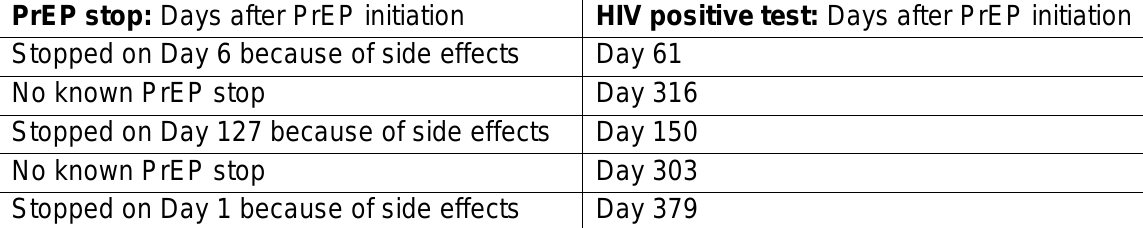
TABLE 3-A1. Timeline of PrEP stops among South African men who have sex with men and transgender women in a combination HIV prevention trial who seroconverted